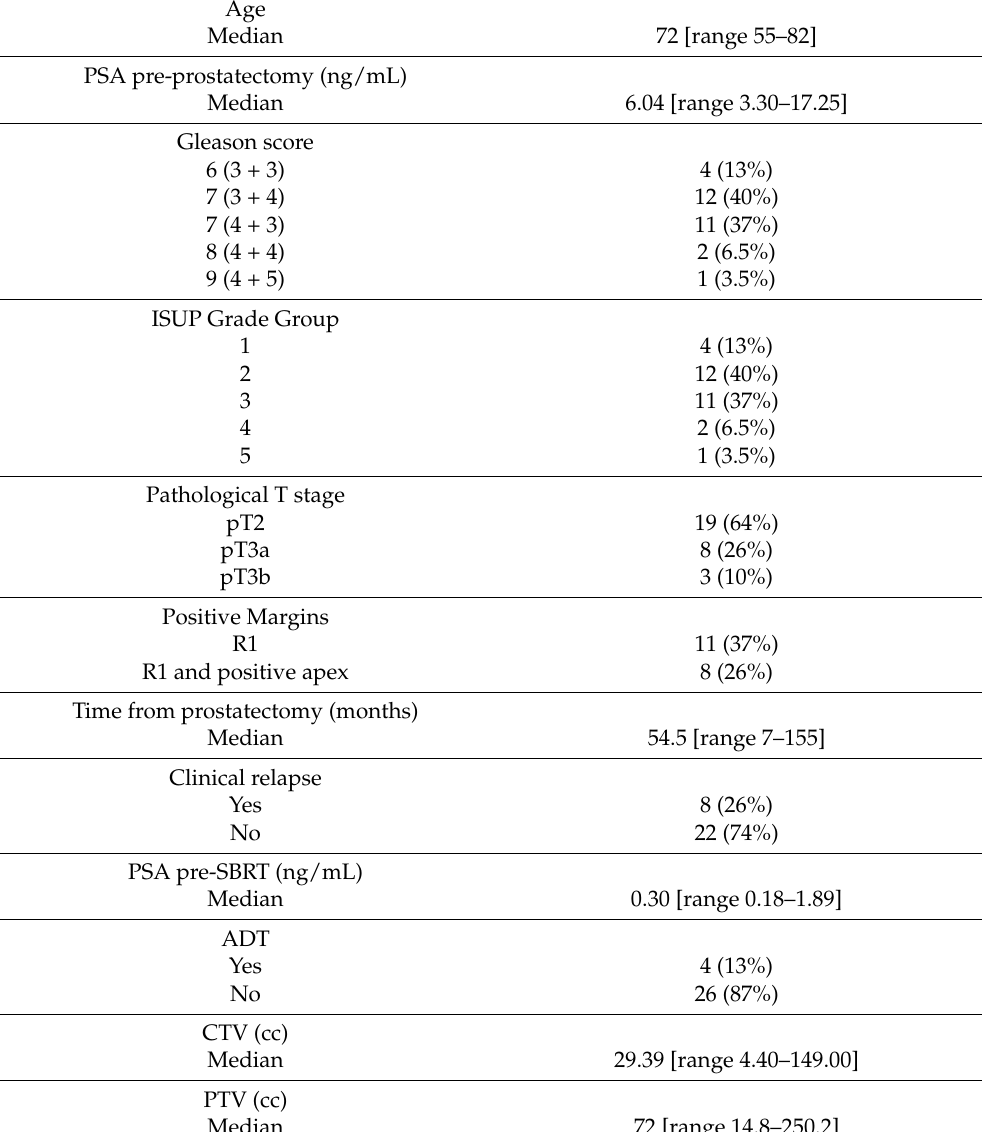
Table 2. Patients, Disease and Treatment Characteristics.